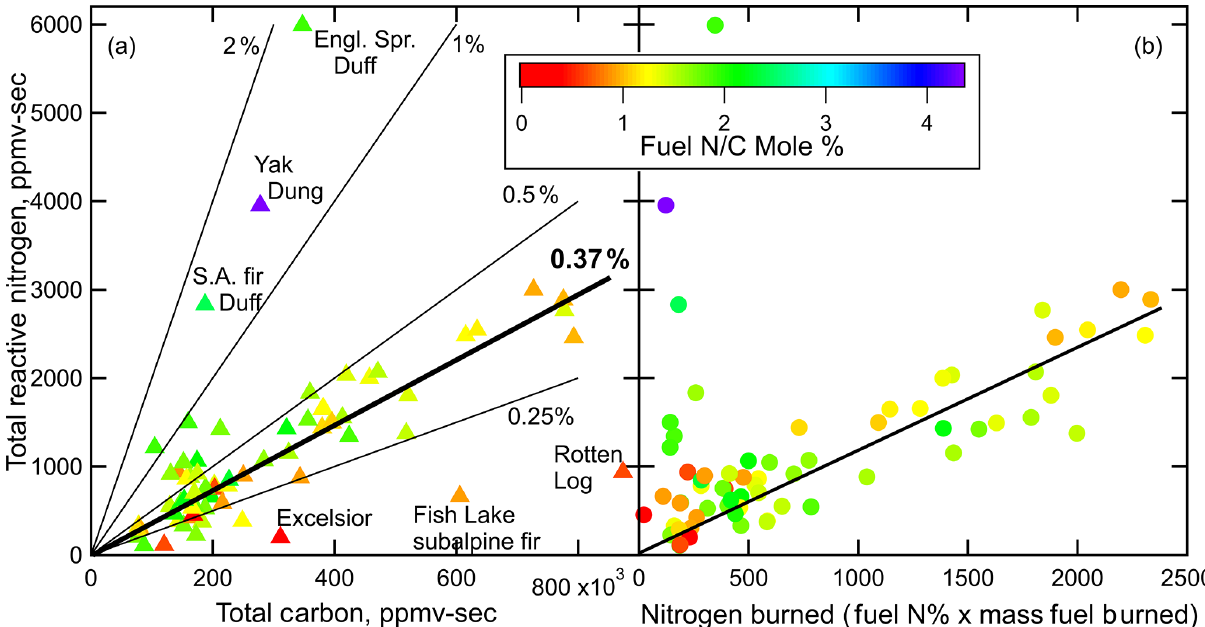
Figure 3. Integrated N r versus (a) integrated total carbon and versus (b) nitrogen burned, based on fuel nitrogen content and mass of fuel burned. The points are colored by fuel nitrogen to carbon ratio. Note that the x and y scales in panel (a) are different by more than a factor of 100.